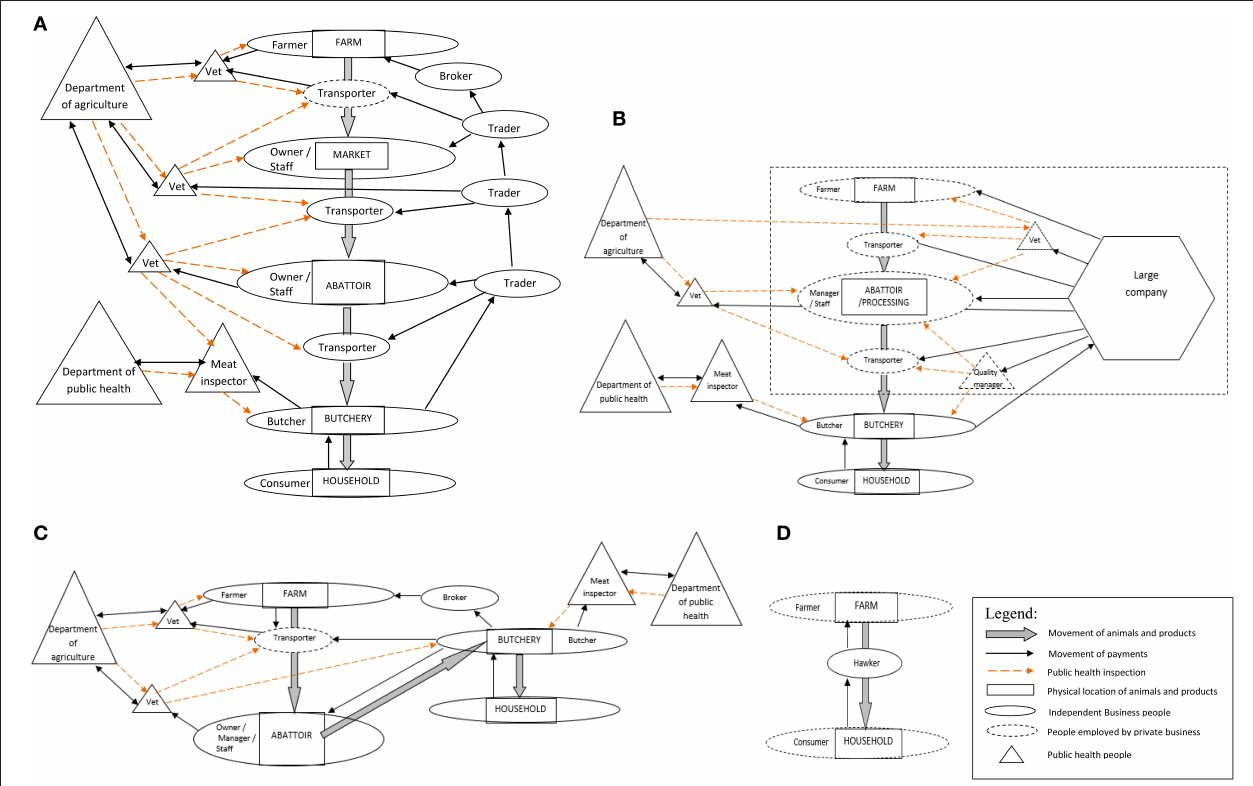
FIGURE 1 | Examples of four types of hypothetical chains which help to indicate the type of connectivity or network of people within the chain and the major influencers. (A) Traders centered. The length and multitude of independent stakeholders suggests more complex interactions which are more difficult to control, with 11 independent business people; 6 public health people; 8 physical locations (inc. transport); 21 total transactions; 10 transactions between independent business; 14 inspection points. All year-around, Long distance, High competition, and No value addition. (B) Company centered; One company controls the chain, making it easier to coordinate and includes private regulation. It includes 3 independent business people; 6 public health people (including 2 private); 6 physical locations (inc. transport); 15 total transactions; 2 transactions between independent business; 10 inspection points (6 private). All year-around, Medium-long distance, Hierarchal structure, and Value addition. (C) Retail (butcher) centered. The Butcher has full information of the chain as it connects farmers to consumers; It includes 4 independent business people; 3 public health people; 5 physical locations (inc. transport); 16 total transactions; 5 transactions between independent business; 8 inspection points. Low season, Short distance, No value addition, and Relational chain. (D) Farm centered short chain with lack of regulation; It includes 2 independent business people; 0 public health people; 3 physical locations (inc. hawker transport); 2 total transactions; 0 inspection points. Short distance, High season, No value addition, and an informal market